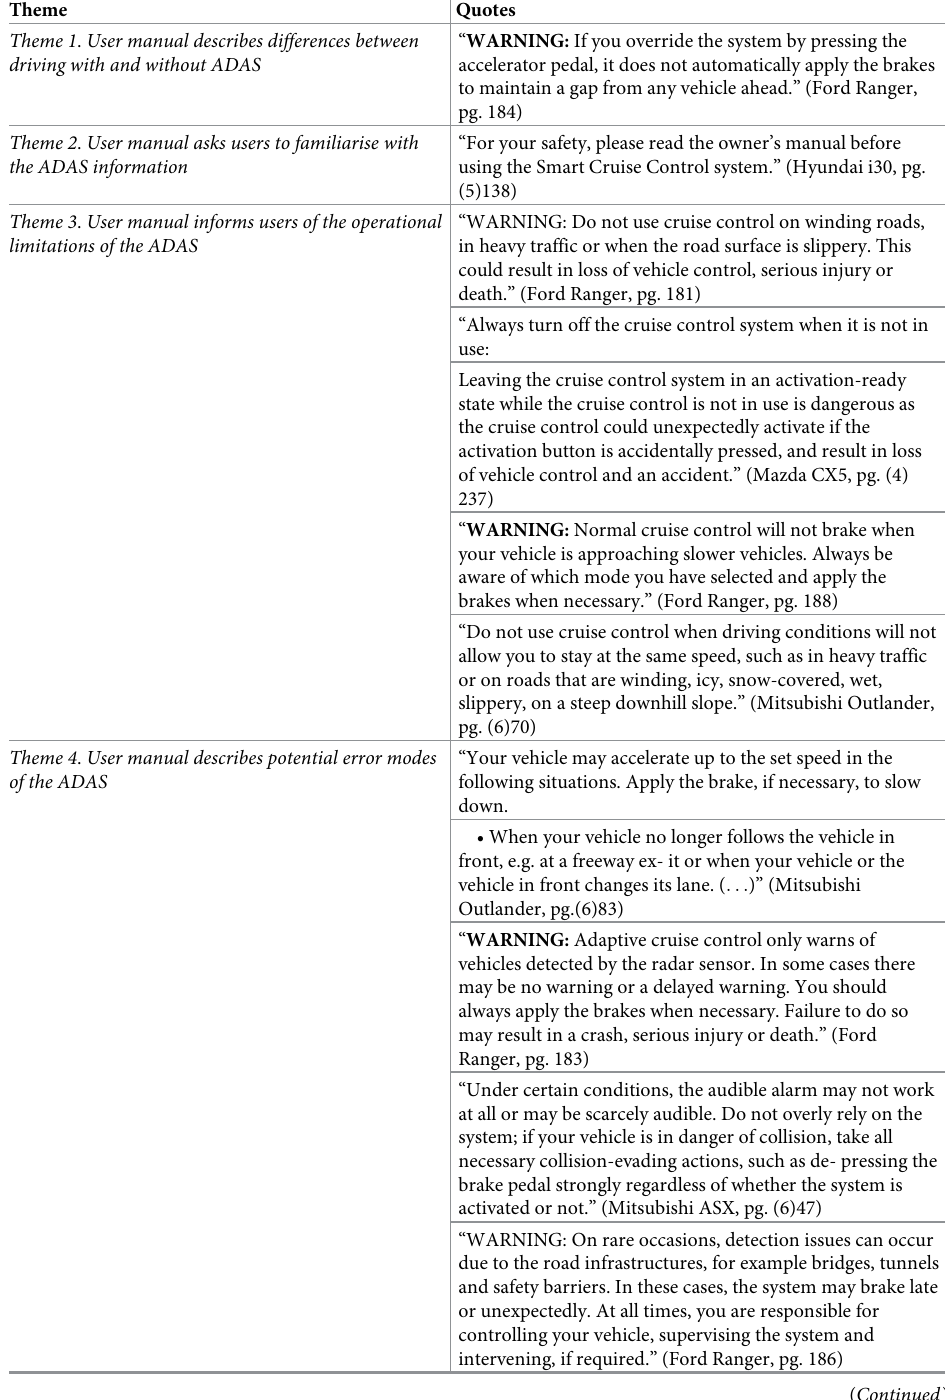
Table 2. Qualitative analysis of cruise control